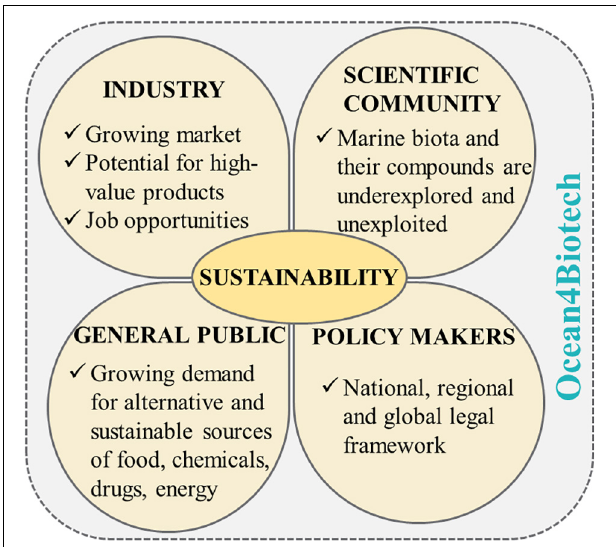
FIGURE 2 | Major prerequisites for the establishment of sustainable actions in marine